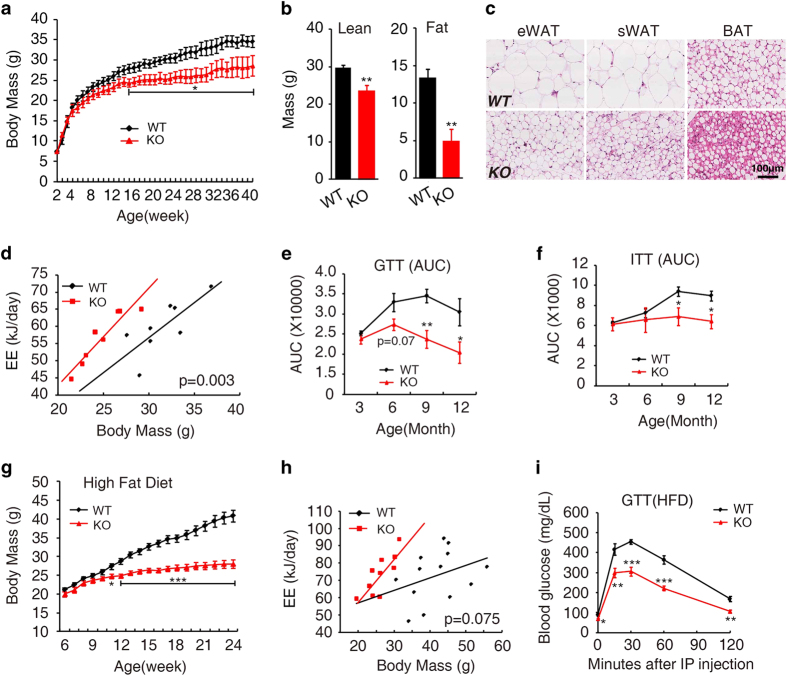
Reduced body mass, increased energy expenditure and improved insulin sensitivity in DJ-1 knockout mice during aging and high-fat diet. (a) Body mass of wild-type (WT) and DJ-1 knockout male mice (KO) fed on a chow diet for 40 weeks (WT, n=10; KO, n=10). (b) Body lean and fat mass of 12-month-old mice measured by MRI (WT, n=7; KO, n=6). (c) Histology of adipose tissue from 12-month-old mice. eWAT, epididymal white adipose tissue; sWAT, subcutaneous white adipose tissue; BAT, brown adipose tissue. (d) Statistical analysis energy expenditure (EE) by General Linear Model (GLM) and ANCOVA analysis of the 6-month-old male DJ-1 KO and WT mice (n=8 per genotype). (e, f) Quantification of the area under the curve (AUC) of GTT (e) and ITT (f) indicated age (n=6 per genotype). (g) Body mass of mice that were fed with a high-fat diet (HFD) (WT, n=14; KO, n=13). (h) Statistical analysis by General Linear Model (GLM) and ANCOVA analysis of the HFD induced indicated genotype mice energy expenditure (EE) (WT, n=13; KO, n=10). (i) GTT was performed in HFD-fed mice with intraperitoneal injection (IP) 2 g kg−1 glucose after fasting 16 h (WT, n=6; KO, n=8).